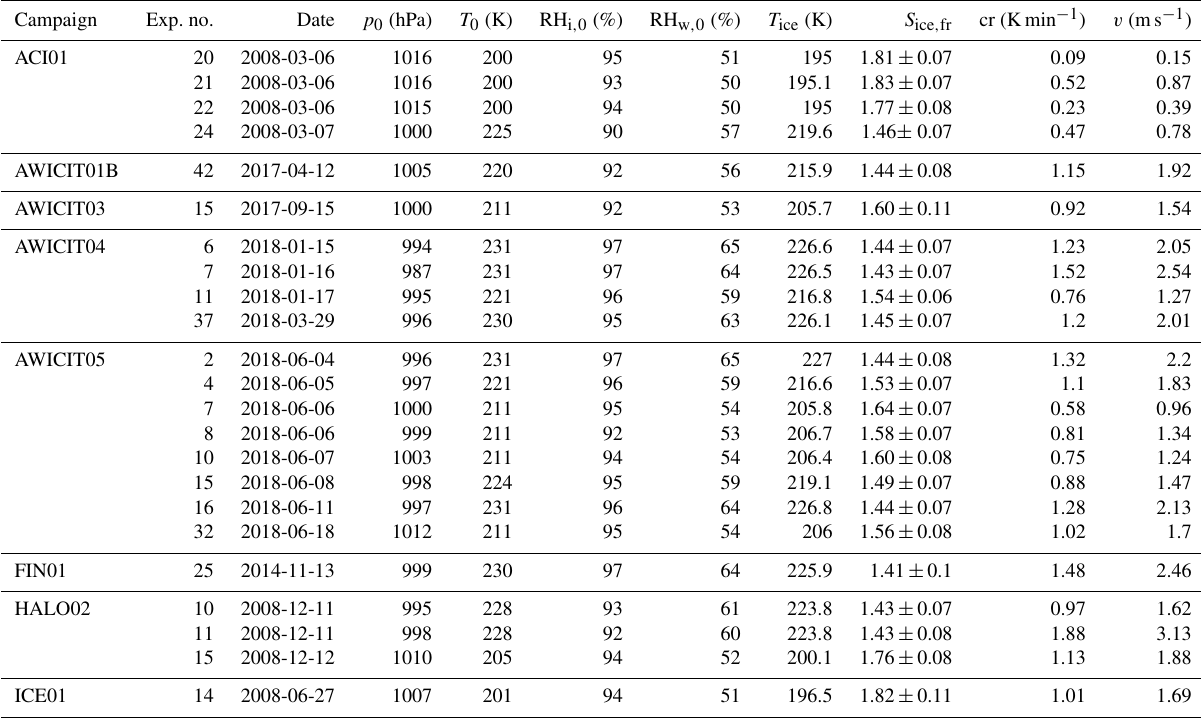
Table B1. Summary of H 2 SO 4 / H 2 O AIDA experiments part I. The considered experiments are listed together with the corresponding campaign, the experiment number, the date of the experiment, the starting pressure p 0 , the starting temperature T 0 , the starting relative humidity with respect to ice RH i , 0 and liquid water RH w , 0 , the freezing onset temperature T ice , the ice saturation ratio at freezing onset S ice , fr , the cooling rate cr, and the corresponding vertical velocity v at the freezing onset. Campaign Exp.